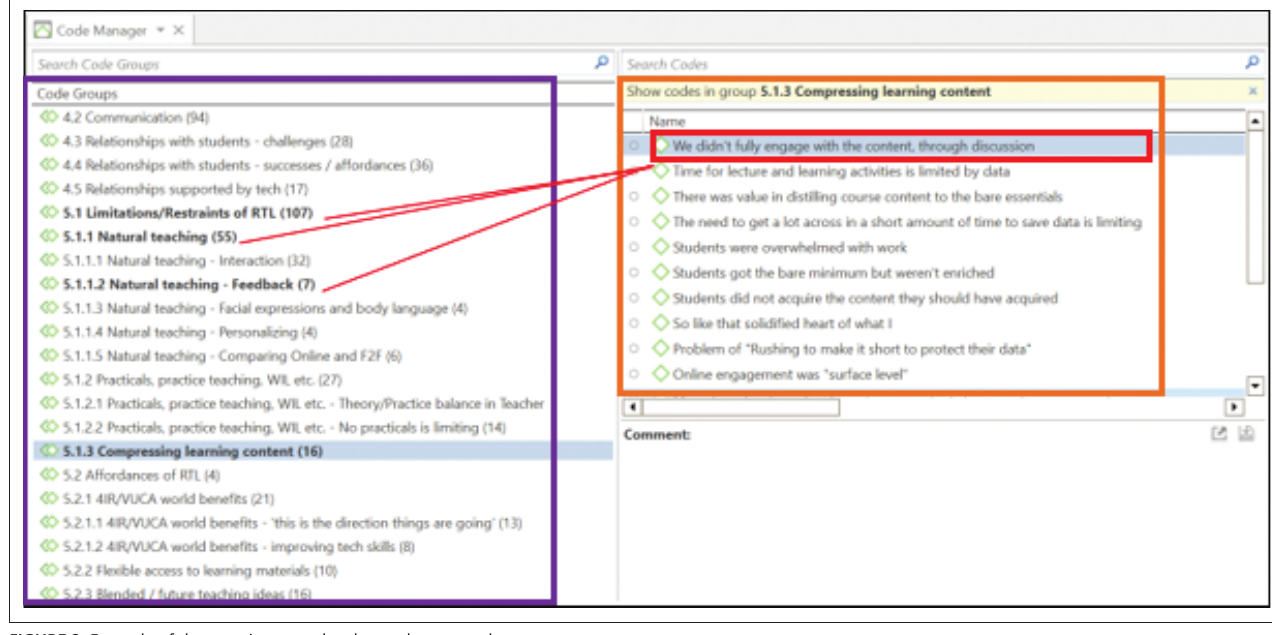
FIGURE 2: Example of the constituent codes that make up a code group.